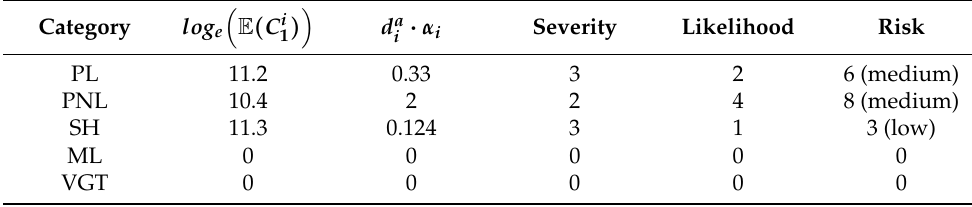
Table A6. Data sheet and scores for each food